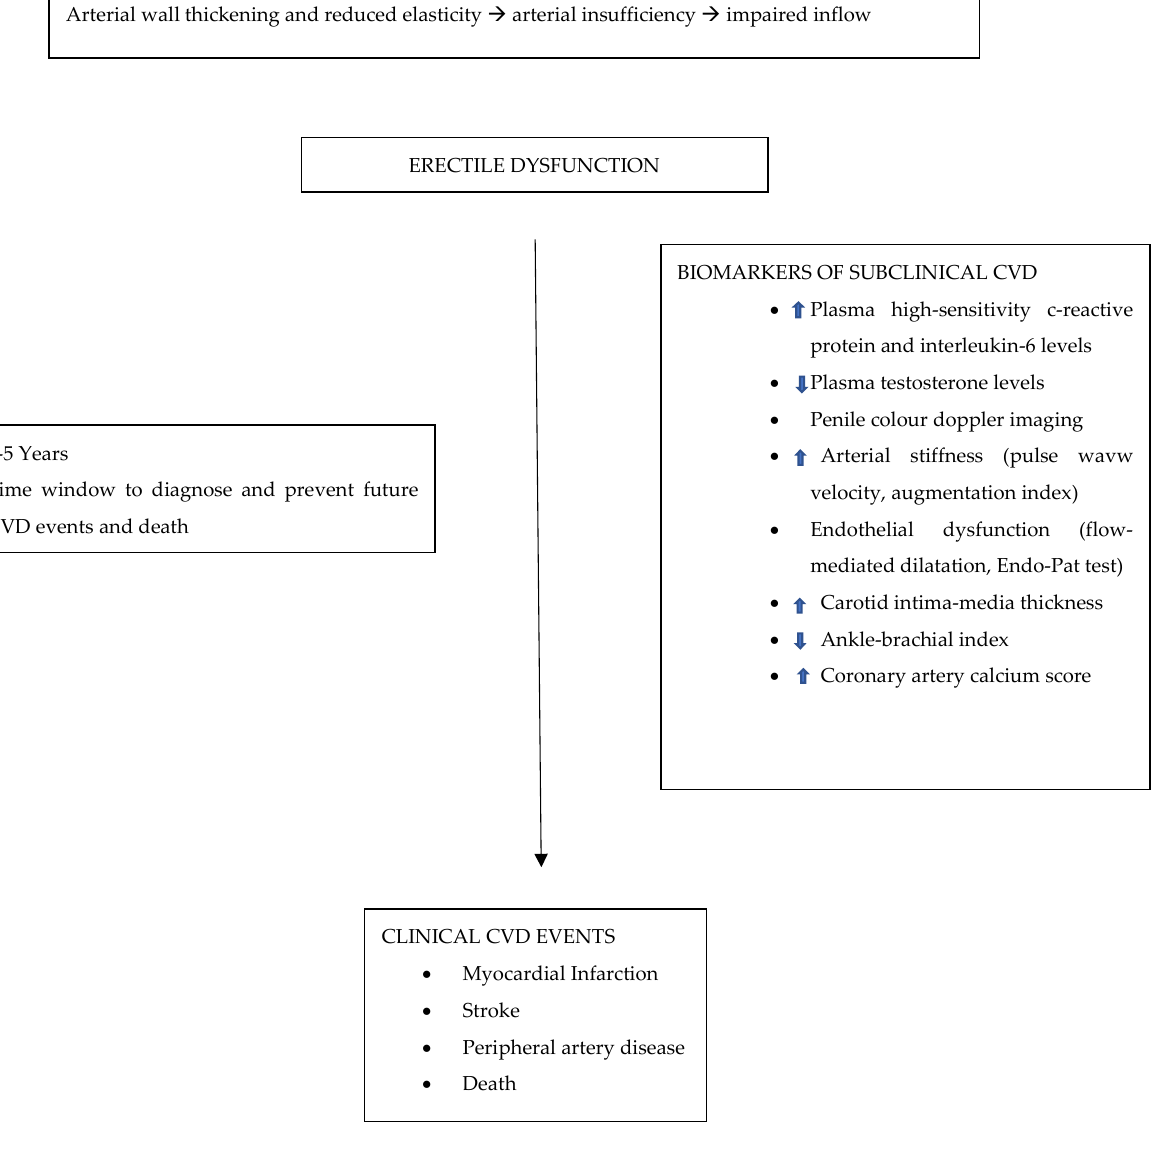
Figure 1. Endothelial Dysfunction and ED